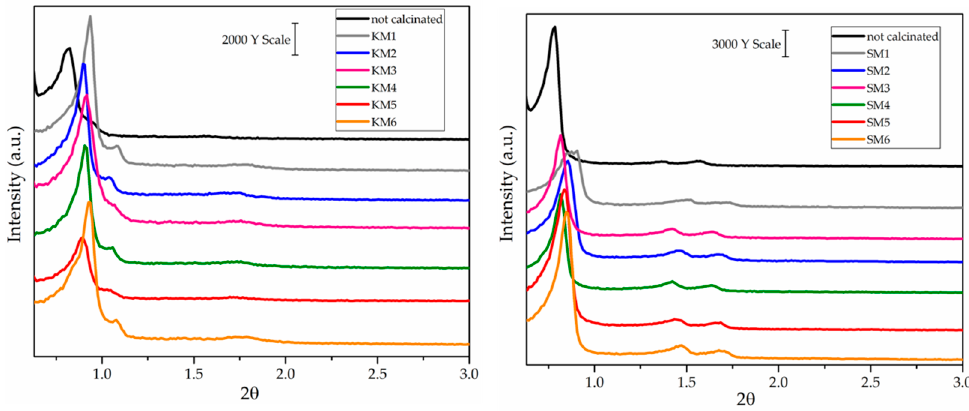
Figure 3. Small-angle XRD pattern of KIT-6 and SBA-15 calcinated under different conditions.